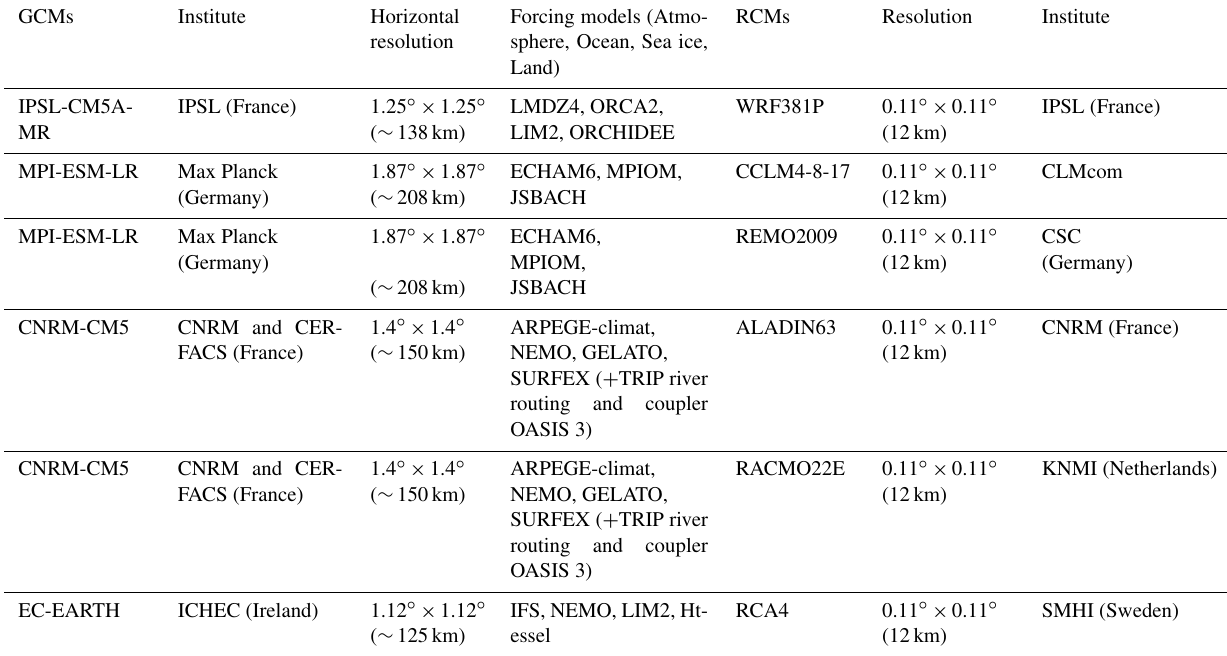
Table 2. Characteristics of the GCMs and of the corresponding RCMs.